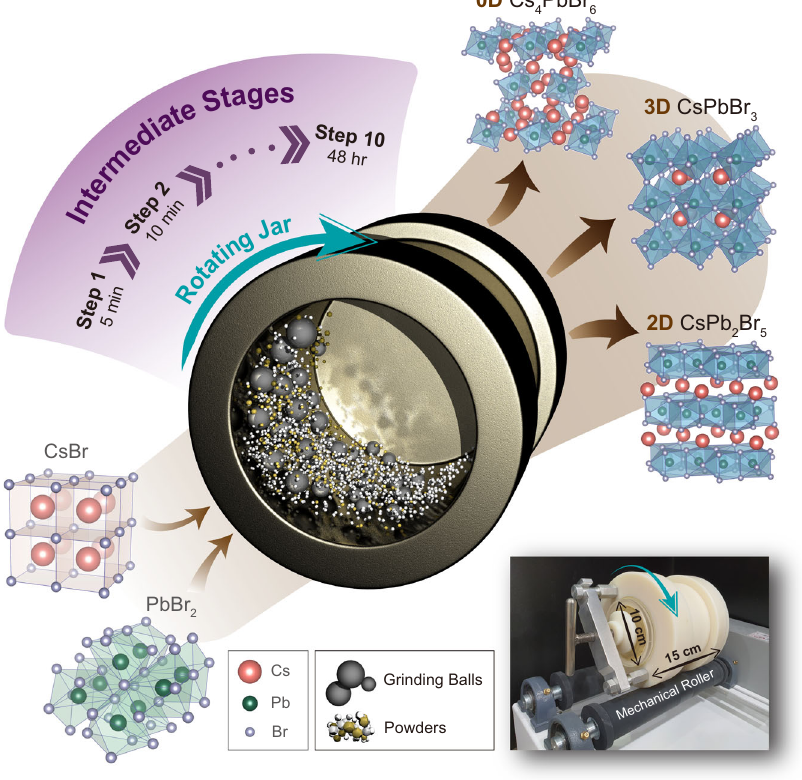
Fig. 1 Rotating mill-type MCS process. Schematic illustration of the overall MCS procedure for the synthesis of perovskite phases. Two precursor salts (CsBr and PbBr 2 ) and grinding balls are put into a container (alumina jar) and rotated continuously. This process results in different Cs – Pb – Br perovskite phases of 0D Cs 4 PbBr 6 , 3D CsPbBr 3 , and 2D CsPb 2 Br 5 . The slow reaction nature of rotating mill-type MCS enables the subdivision of intermediate process into several steps, which allows precise observation of intermediate phases. Crystal structures of precursors and each perovskite phase are schematically presented. The fi gure in the bottom – right shows a photograph of our experimental